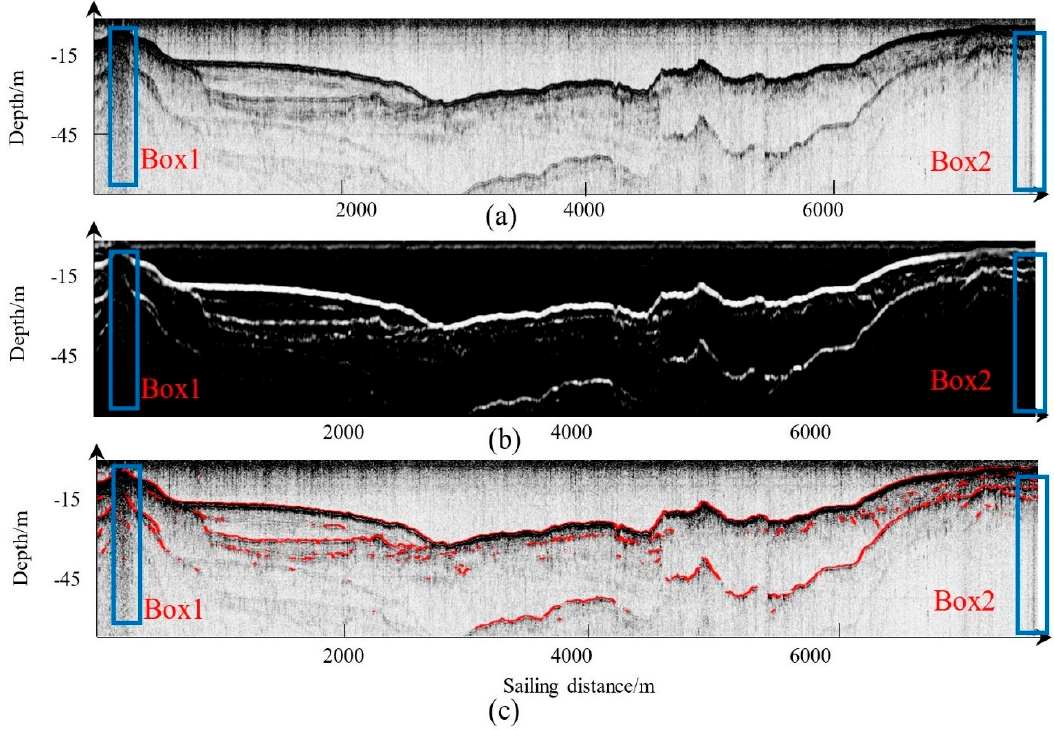
Figure 12. The original SBP image and the resulting images. ( a ) shows the original SBP image. ( b ) shows the filtered image. Picking horizons from ( b ), ( c ) shows the superposition of picked horizons and the original SBP image. Blue boxes show the areas having vertical structures.